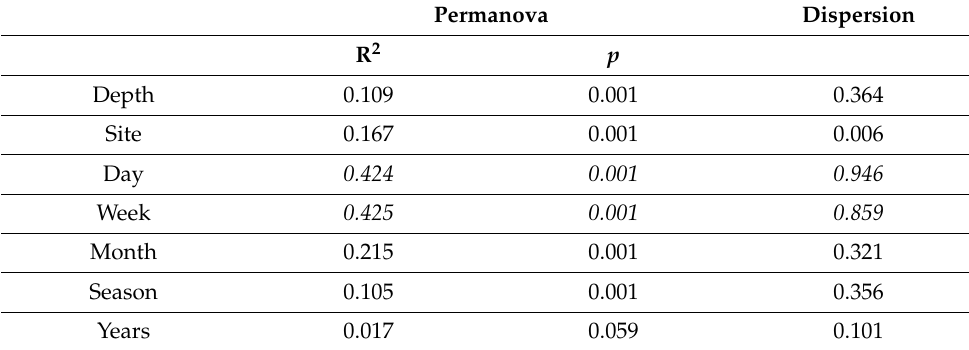
Table 2. Spatio-temporal analysis using Permanova. The best explanatory variables for microbial diversity are presented in italics.